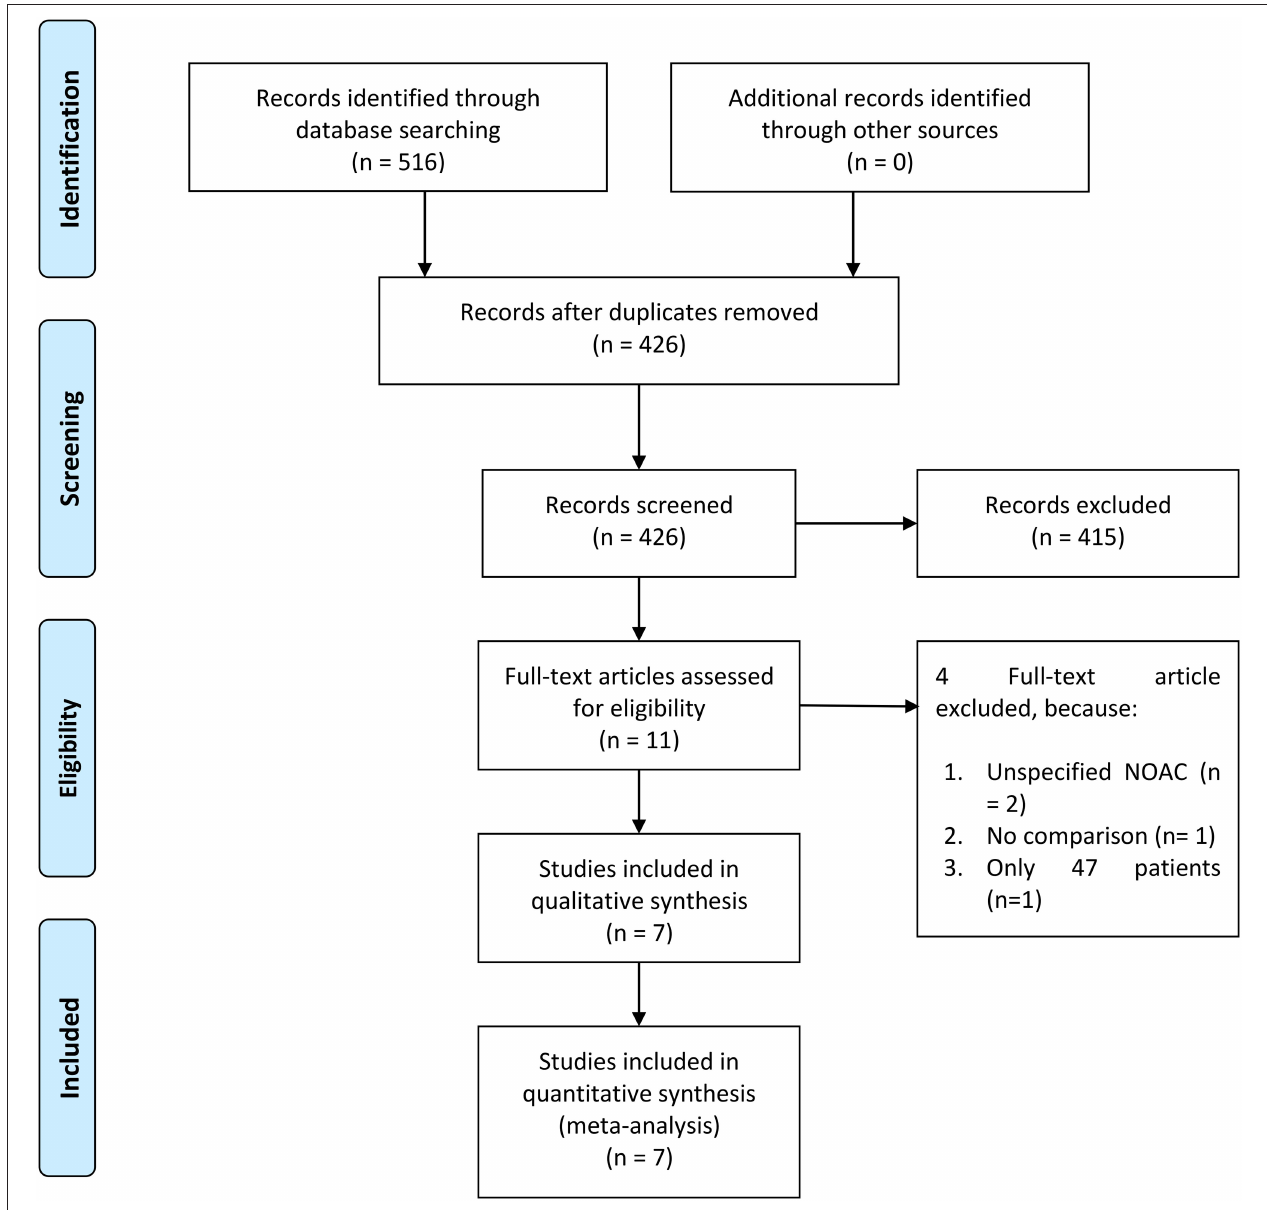
FIGURE 1 | Preferred reporting items for systematic reviews and meta-analysis (PRISMA)